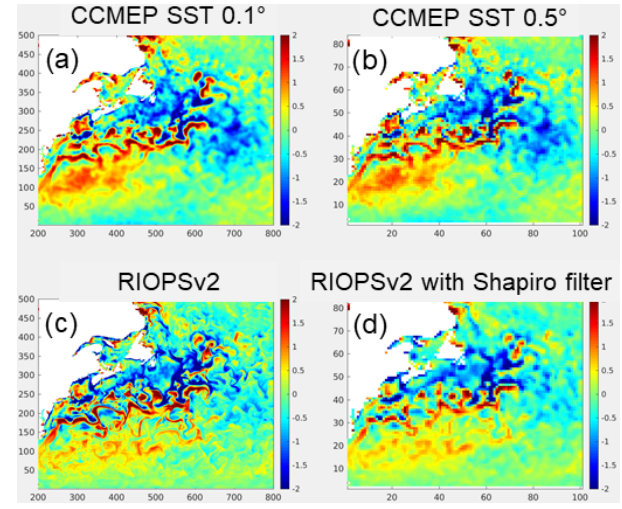
Figure 4. Example illustrating the SST filtering made as part of the observation operator in RIOPSv2 for 20 July 2016. The CCMEP SST analysis assimilated by RIOPSv2 is shown on its na- tive 0.1 ◦ latitude–longitude grid in panel (a) . This analysis is first decimated to 1 point out of 5 to reduce correlated errors (b) . The RIOPSv2 7d trial field is shown in panel (c) . Finally, the trial field following application of a Shapiro filter is shown in panel (d) . The innovation is calculated as panel (b) minus (d)